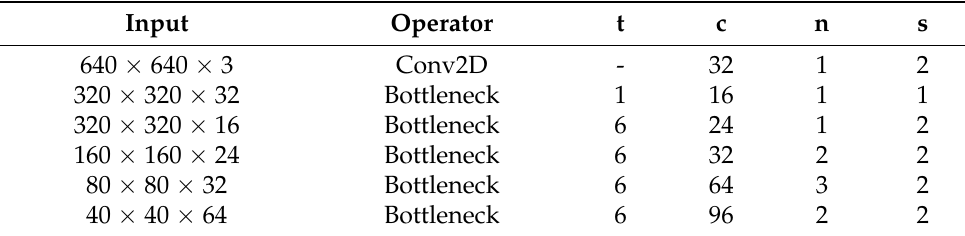
Table 1. Design of the backbone network